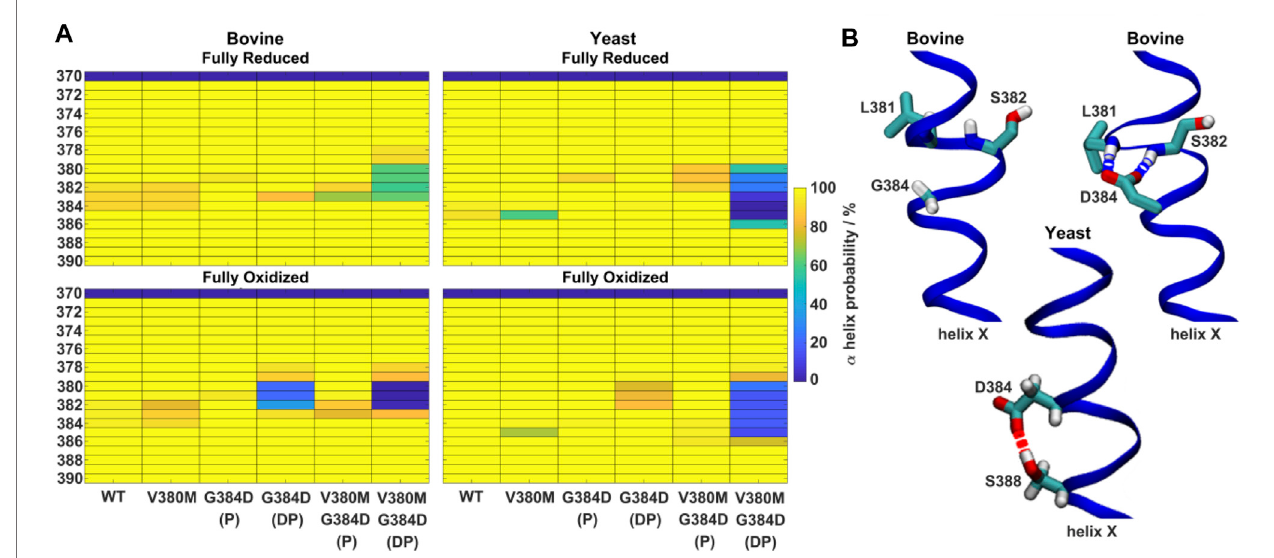
FIGURE 4 | α -helicity of TMH X and hydrogen bonding rearrangements. (A) α -helix probability (%) of TMH X in WT, V380M, G384D (P/DP) and double mutant V380M/G384D (P/DP) bovine (left) and yeast (right) C c Os in their fully reduced (top) and oxidized (bottom) states. P (protonated) and DP (deprotonated) denote the protonationstateofD384. (B) ConformationofTMHXinWTandtheG384D(DP)mutantofbovineC c O (top) andtheG384D(DP)mutantofyeastC c O (bottom) .L381, S382, G384/D384, and S388 are labelled. Hydrogen bonds connecting D384 with the backbones of L381 and S382 or the sidechain of S388 are indicated by dashed blue and red lines,